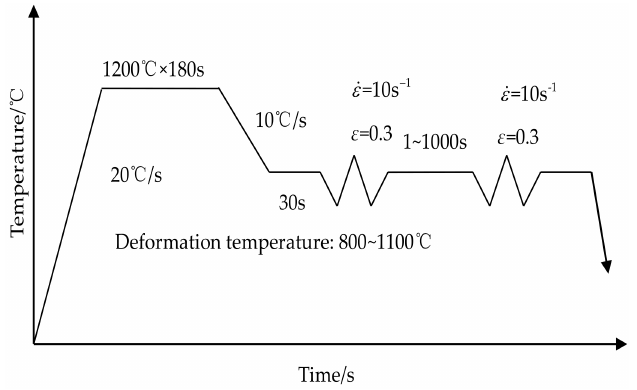
Figure 1. Schematic illustration of the double-pass compression tests.